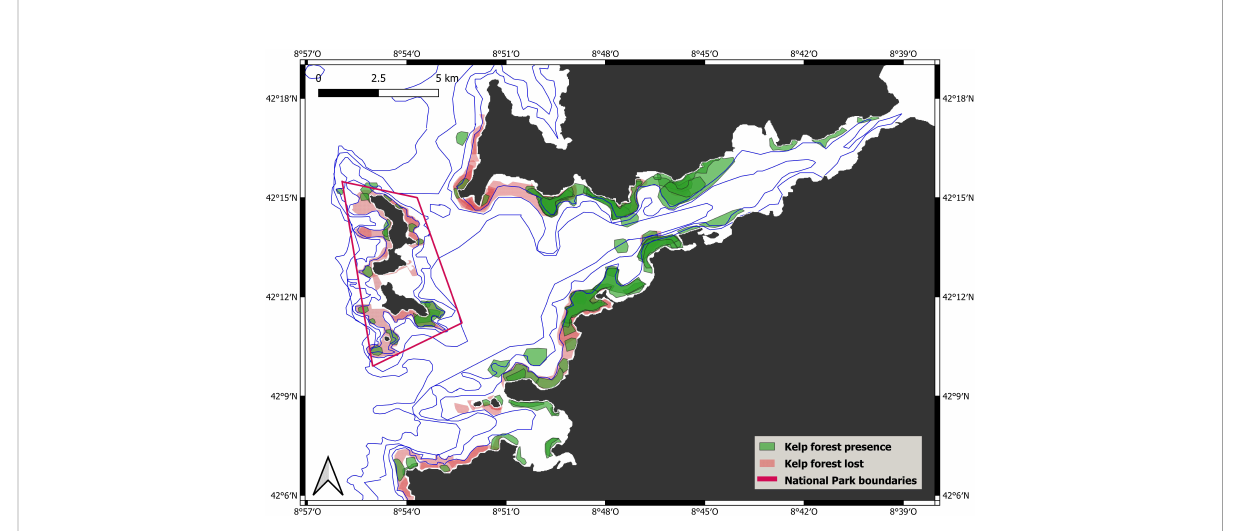
FIGURE 2 Kelp forest distribution in the study area inferred from local ecological knowledge. The map integrates the information provided by local small- scale fi shers on the current (kelp forest present) and historical (kelp forest lost) occurrence of kelp forest areas in R ı ́ a de